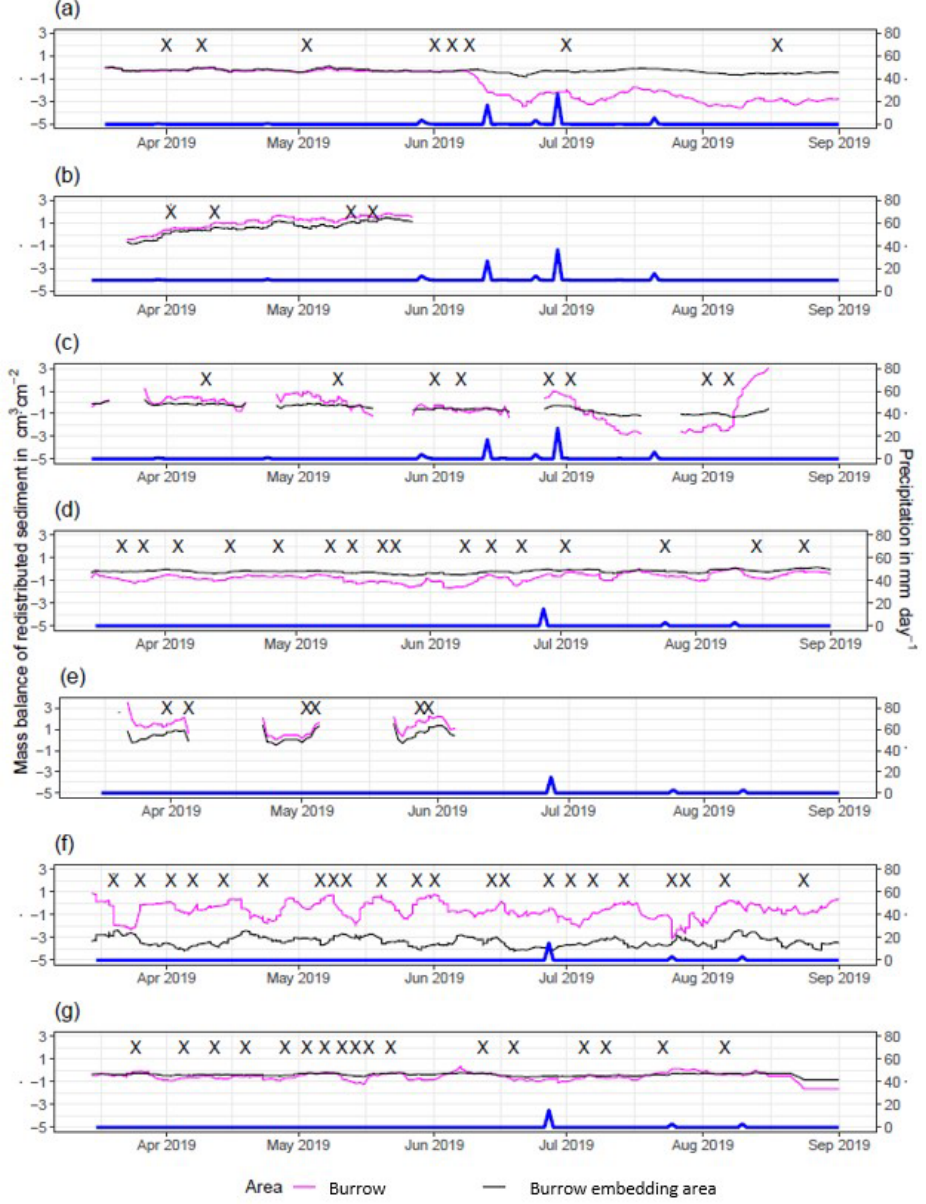
Figure A4. Sediment mass balance for the period of 7 months shown separately for burrows and burrow-embedded areas as measured by the cameras: (a) LC-NU, (b) LC-SU, (c) LC-SL, (d) PdA-NU, (e) PdA-NL, (f) PdA-SU, and (g) PdA-SL. For definitions of the abbreviations, see Table